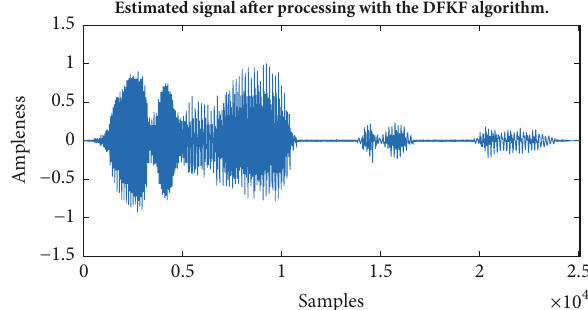
Figure 3: Estimated signal after processing with the DTKF algo- rithm.